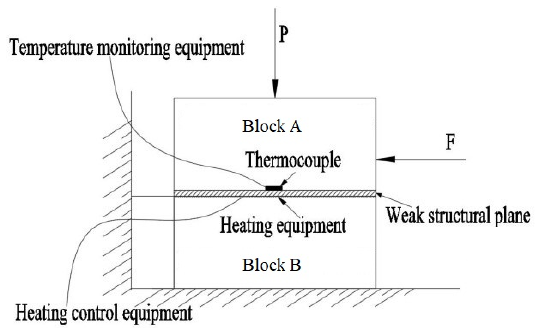
Figure 4. Layout of the temperature control system.